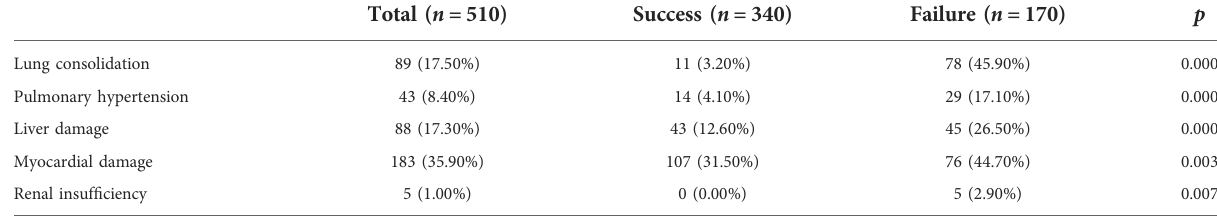
( Figure 5 ). Hosmer-Lemeshow goodness-of- fi t tests revealed no signi fi cant difference between observed and predicted events ( p = 0.8606) ( Figure 6